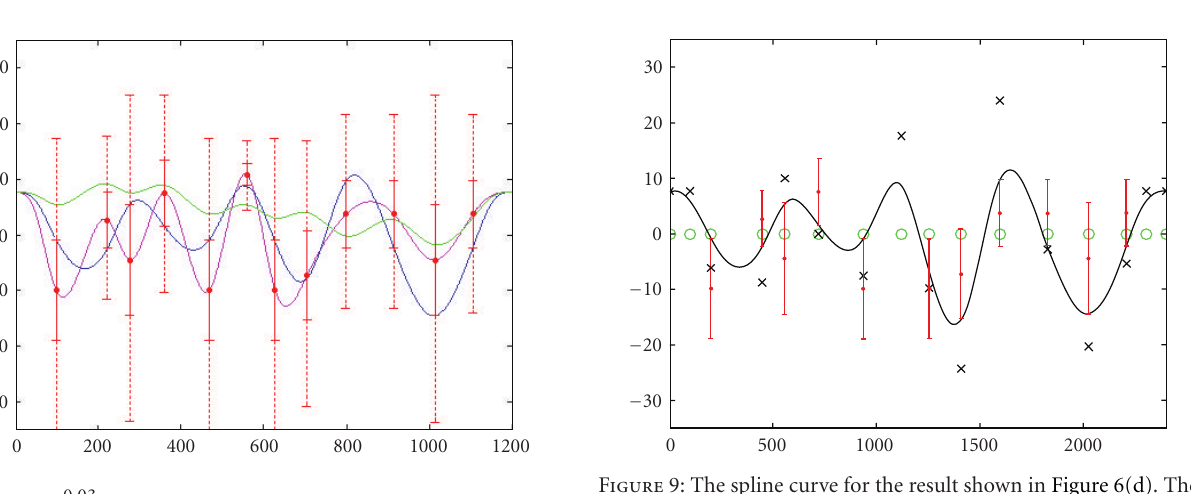
Figure 9: The spline curve for the result shown in Figure 6(d). The global constraint is set to 0.002, and all range constraints are met. The duration of the speech (horizontal axis) is twice as long as Figure 7. The green circles illustrate the knot spacing of the spline, and the x’s represent the control points. The solid vertical red bars show the range constraints.